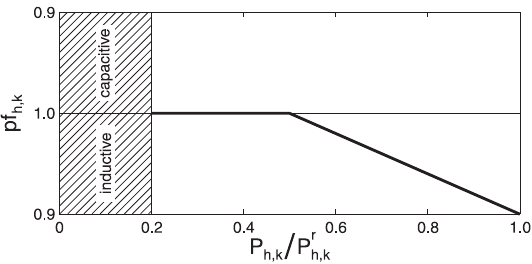
Figure A1. Power factor characteristic for medium/large DG plants